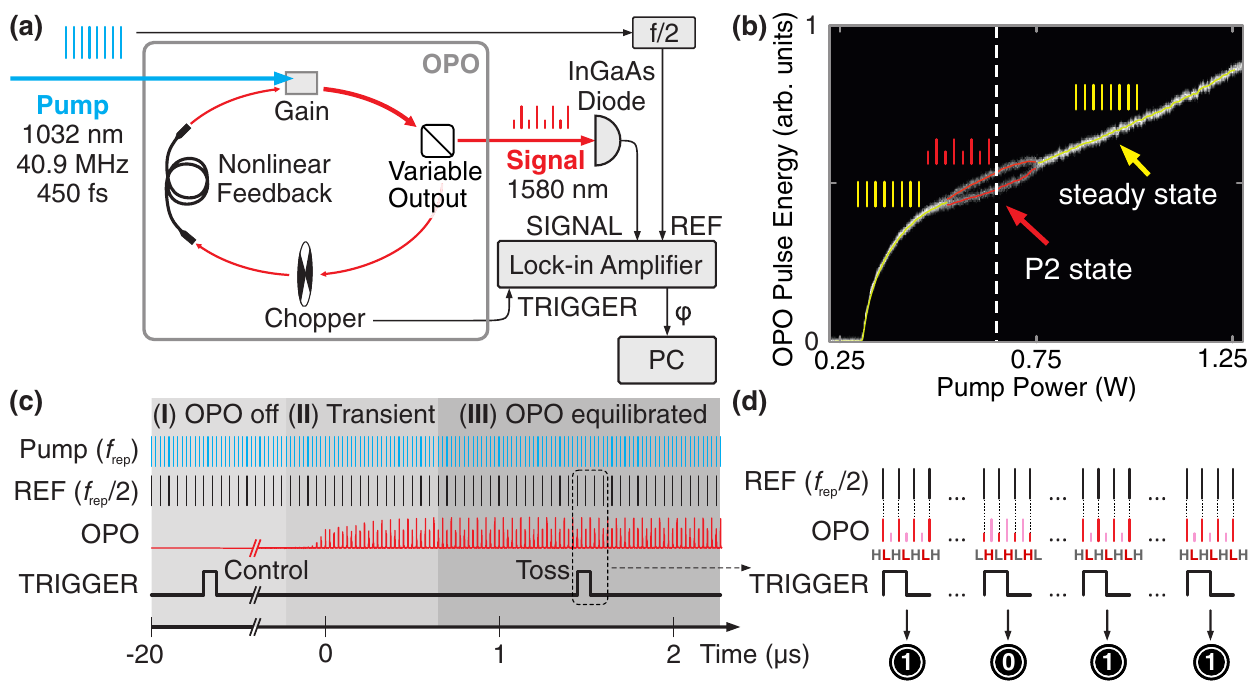
FIG. 2. Experimental scheme of randomness generation. (a) Experimental implementation of the optical parametric oscillator. (b) Power-dependent output pulse energy. Note that both different output pulse train options are equienergetic. (c) Measured transition scheme, periodic with the chopper frequency. The trigger pulse defines two measurements: one when the OPO is blocked (control), and one when the P2 regime is reached (toss). The reference frequency is 40 . 9 MH z= 2 , supplied by the pump laser and a frequency divider. (d) Interpretation of measurement outcomes as final